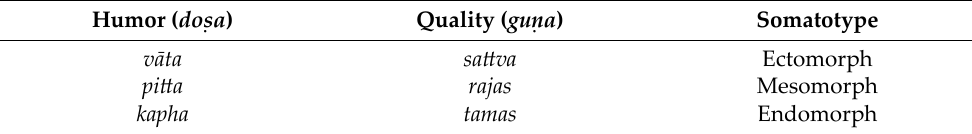
Table 5. Humors and qualities in traditional Indian medicine. Humor ( dos a ˙